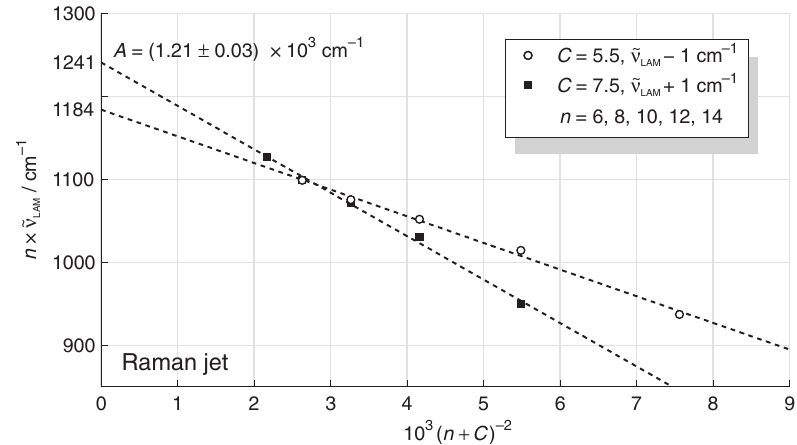
Figure 4. Extrapolation of deperturbed Raman jet LAM-1 wavenumbers to in fi nite chain length ( n ).